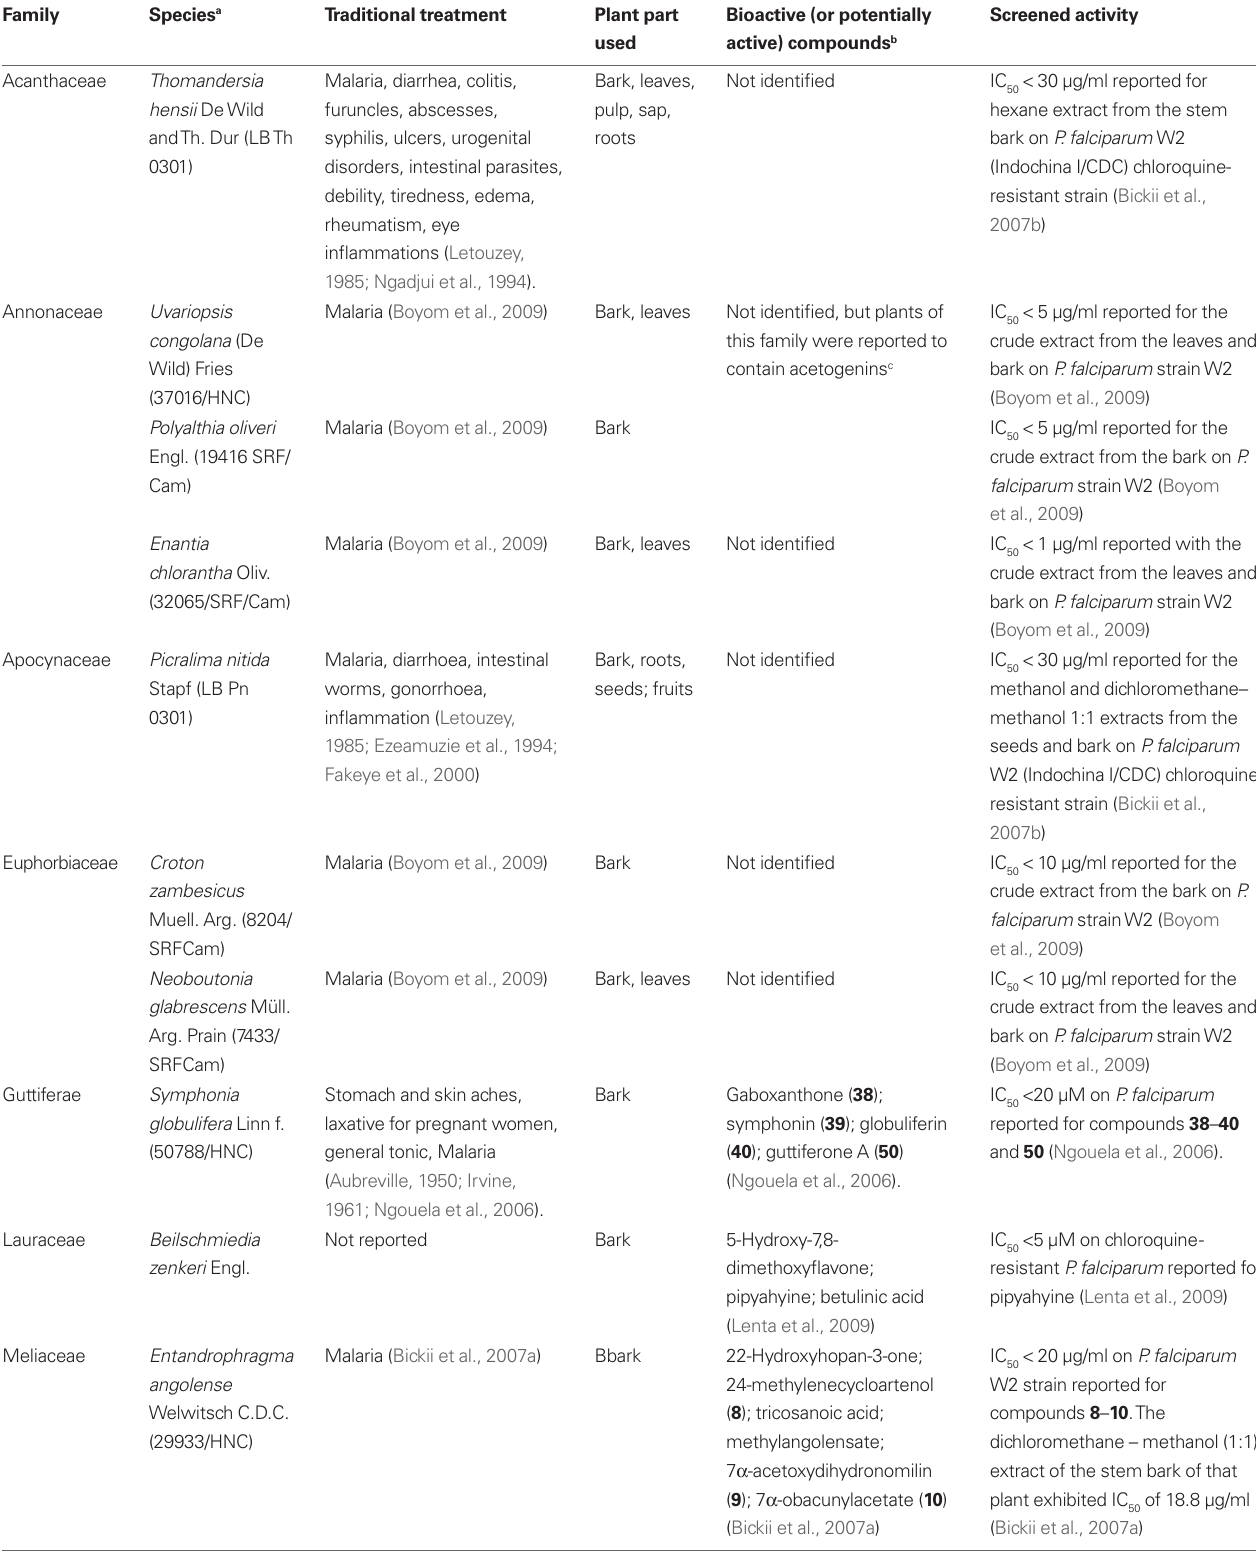
Table 2 | Plants used in Cameroon to treat malaria, with evidence of their activities.